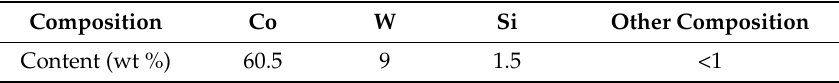
Table 1. CoCr alloy